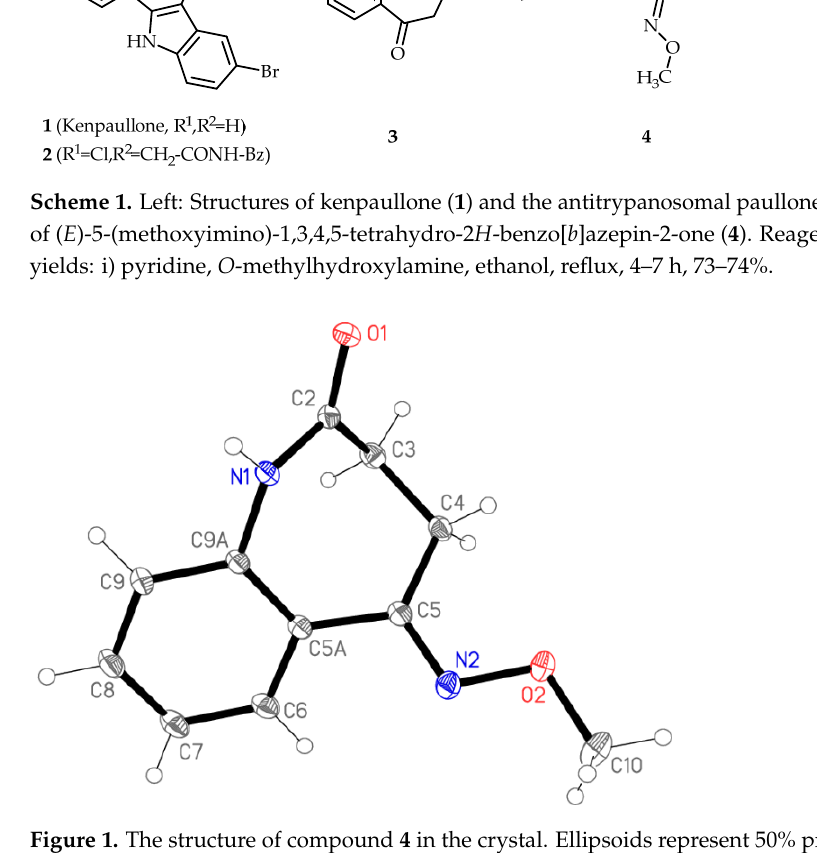
Figure 1. The structure of compound 4 in the crystal. Ellipsoids represent 50% probability levels. Selected bond lengths [Å], bond angles and torsion angles [°]: N(2)-C(5) 1.2903(10), N(2)-O(2) 1.4133(8), C(4)-C(5) 1.5058(10), C(5)-C(5A) 1.4845(10), C(10)-O(2) 1.4315(10), C(5)-N(2)-O(2)